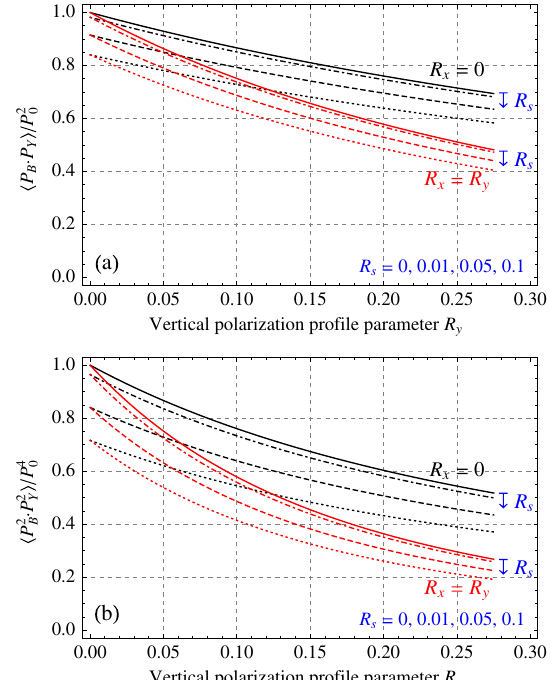
FIG. 3. For double spin colliding beam experiments (a) rela- tive reduction of the average polarization function h P B (cid:2) P Y i =P 2 0 , and (b) relative reduction of the figure of merit h P 2 B (cid:2) P 2 Y i =P 4 0 , as a function of the vertical profile parameter R y . Assuming the same polarization profiles in both beams the cases R x ¼ 0 and ¼ R R ¼ 0 ; 0 : 01 ; 0 : 05 ; 0 : 1 R x y are shown for s